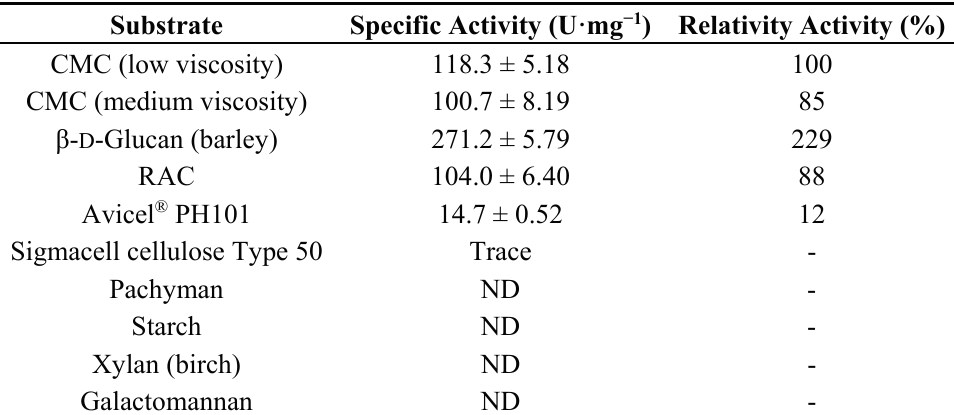
Table 1. Substrate specificity of